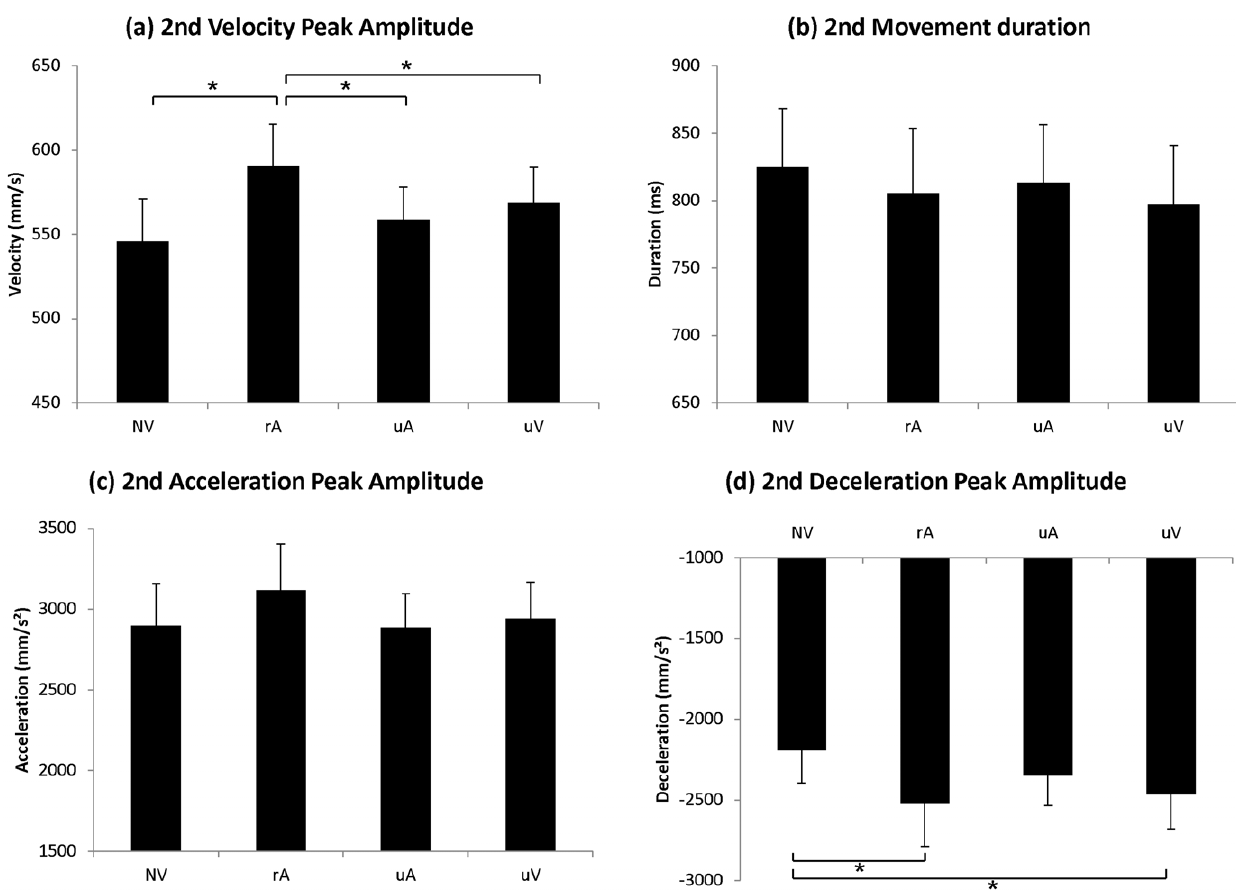
Figure 6. Experiment II: Kinematic parameters of the ‘‘Lift-to-Displace’’ movement. Mean values of (a) wrist velocity peak amplitude and (b) movement duration (c) wrist acceleration peak amplitude and (d) wrist deceleration peak amplitude. Error bars represent standard error of the mean (SEM). *p , 0.05.